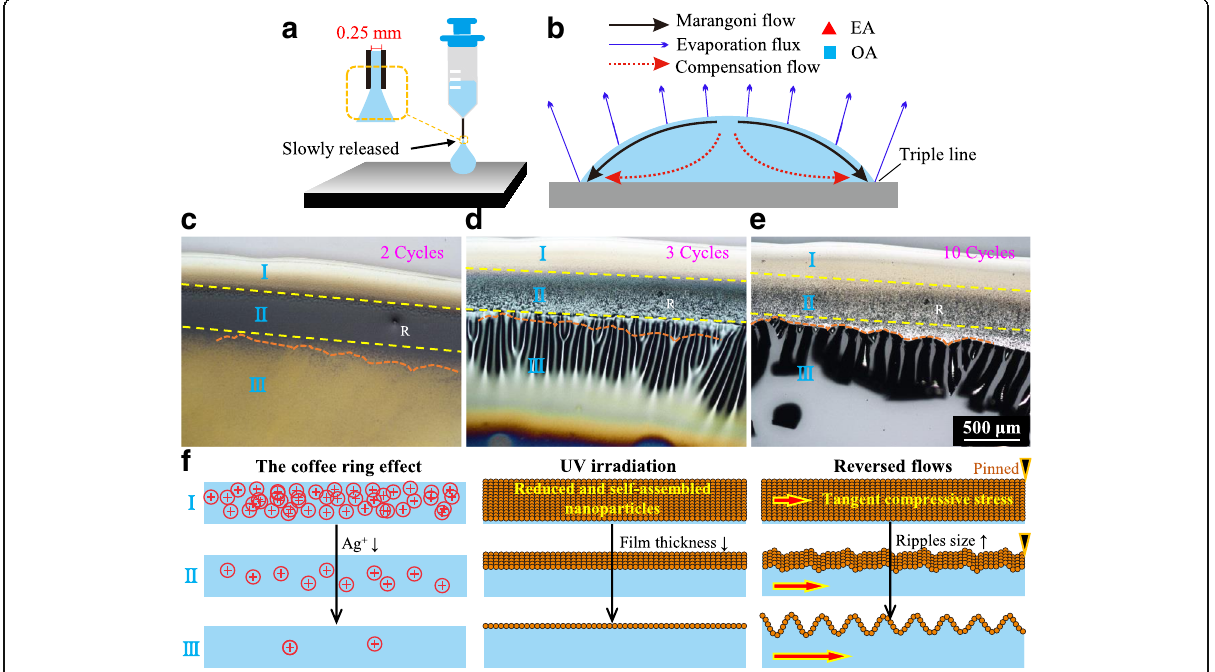
Fig. 1 Crack formation process. a Droplet released by a syringe. b Schematic of the induced directional flows. c , d , e The released droplets followed by cycles of UV irradiation. f Schematic of different morphologies for different